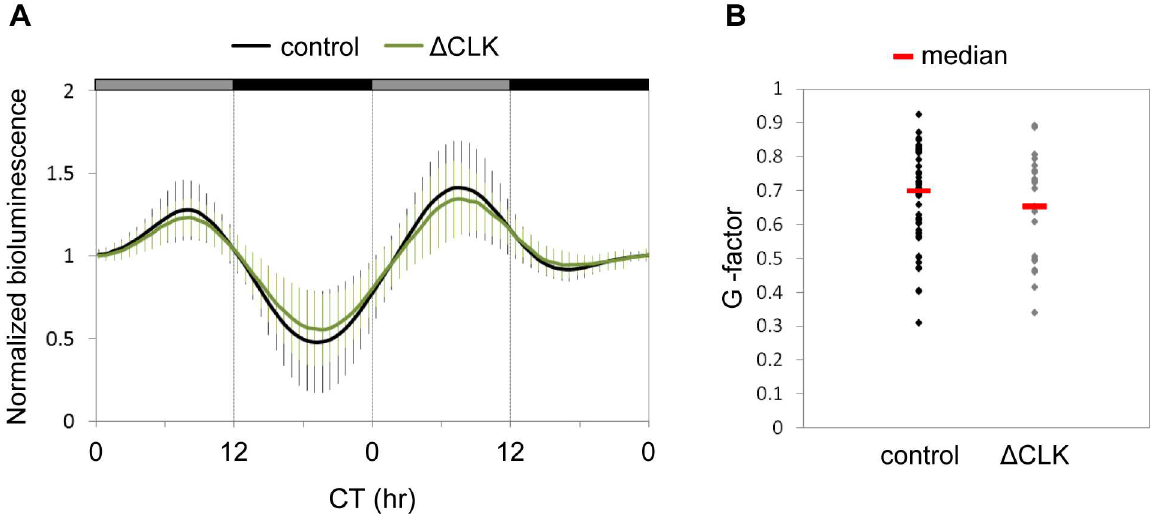
Fig 6. Circadian rhythms of per1b promoter activity in whole larvae are not affected by the pineal Δ CLK mutation. (A) Mean bioluminescence of Tg[ aanat2 :EGFP- Δ CLK;( − 3.1) per1b ::luc] larvae( Δ CLK; green trace; n = 23) and Tg( − 3.1) per1b ::luc larvae (control; black trace; n = 55), starting from 5 dpf for two daily cycles under DD. Circadiantime (CT) is plotted on the x-axis. Gray and black bars represent subjectiveday and subjectivenight, respectively. Error bars represent SD. (B) Distributionof the G-factors (a representation of the extent to which the frequencyof the luciferaseactivity pattern corresponds to a 24-hr period; see ’Fourier analysis’in S1 Text) of Δ CLK and control larvae. The medianG-factor value for each group is indicated(red